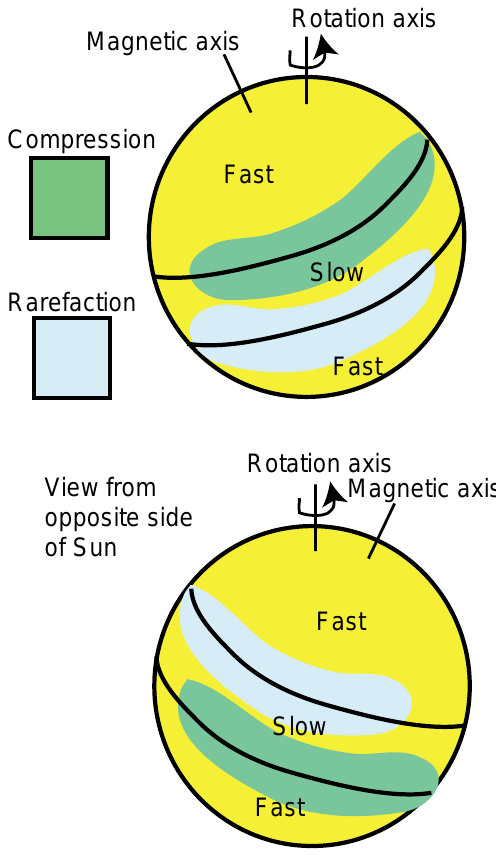
Fig. 6. Schematic of formation and orientation of streams at solar minimum.